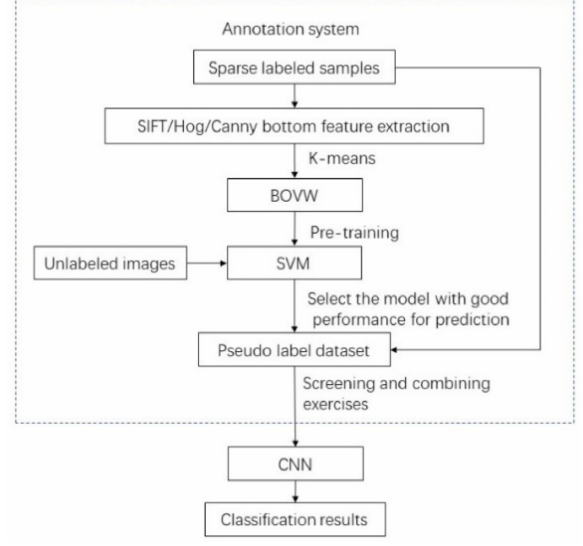
Figure 4. BOVW_SVM_ VGG16 algorithm flow